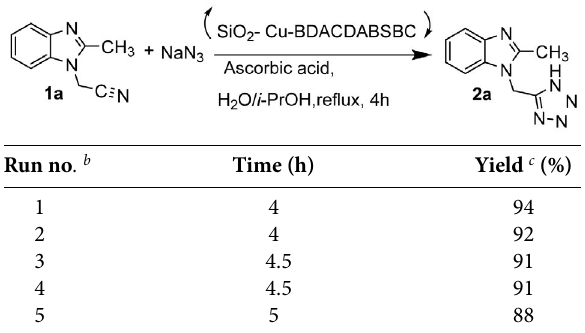
Table 5. The reusability of SiO 2 -Cu-BDACDABSBC in successive runs for the synthesis of 2a . a